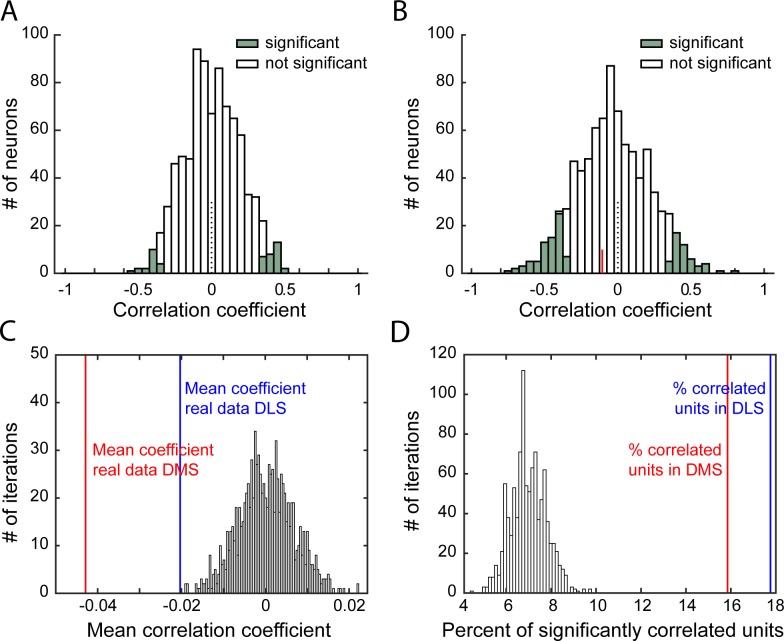
Characterization of correlations relating within-sequence firing rate and response rate.(A–B) Distribution of Spearman rank correlation coefficients from 1 iteration of the shuffled data (A) or from the real data (B), relating shuffled (A) or non-shuffled (B) within-sequence firing rate (from 1st to last lever press) to the animal’s response rate on a trial-by-trial basis. Bars shaded show significant correlations. In B, the red line indicates the median correlation coefficient of the correlated neurons. (C–D). Distribution of mean Spearman correlation coefficients (C) and percentage of significantly correlated units (D) from 1000 shuffled iterations of within-sequence firing rate and response rate, on a trial-by-trial basis. On both graphs, vertical lines indicates values from real data in DLS (blue) or DMS (red).